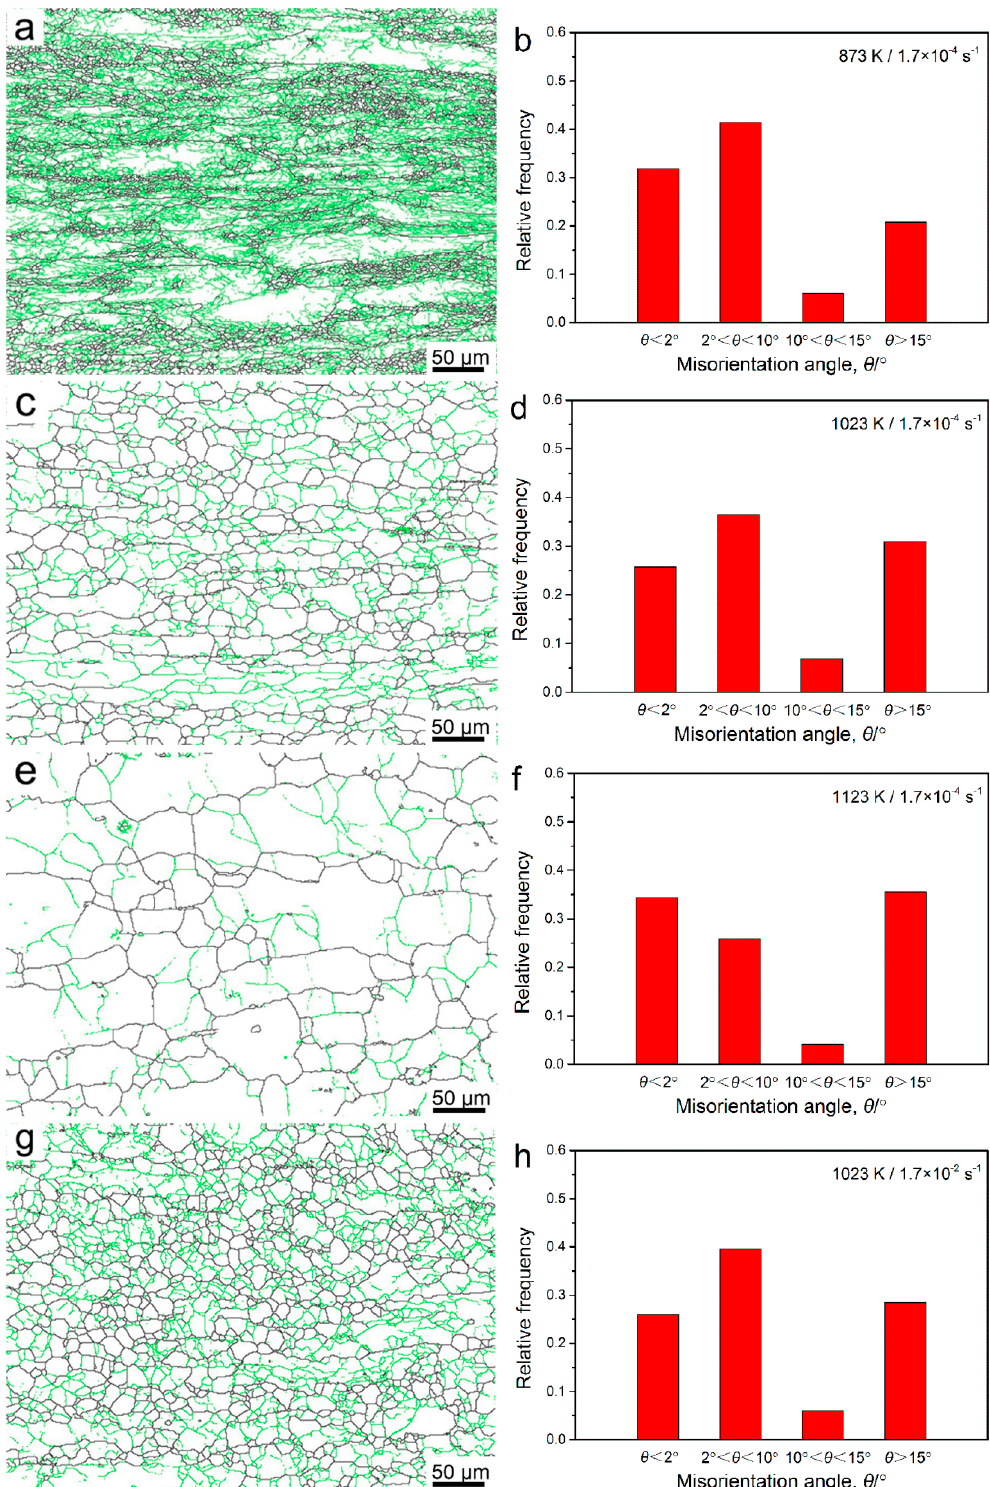
Figure 10. The distribution of grain boundary for the 0Cr18AlSi steel tested under different deformation conditions: ( a ) and ( b ) 1.7 × 10 − 4 s − 1 and 873 K; ( c ) and ( d ) 1.7 × 10 − 4 s − 1 and 1023 K; ( e ) and ( f ) 1.7 × 10 − 4 s − 1 and 1123 K; ( g ) and ( h ) 1.7 × 10 − 2 s − 1 and 1123 K. Green lines correspond to boundaries with low misorientation 2° < θ < 15°, and black lines θ > 15° represent high-angle boundaries. Kernel average misorientation (KAM) maps corresponding to the Figure 6 are shown in Figure 11. The KAM value can be recognized as an indicator of dislocation density. The higher the KAM value, the higher the dislocation density. At 1.7 × 10 − 4 s − 1 and 873 K (Figure 11a), it is observed that